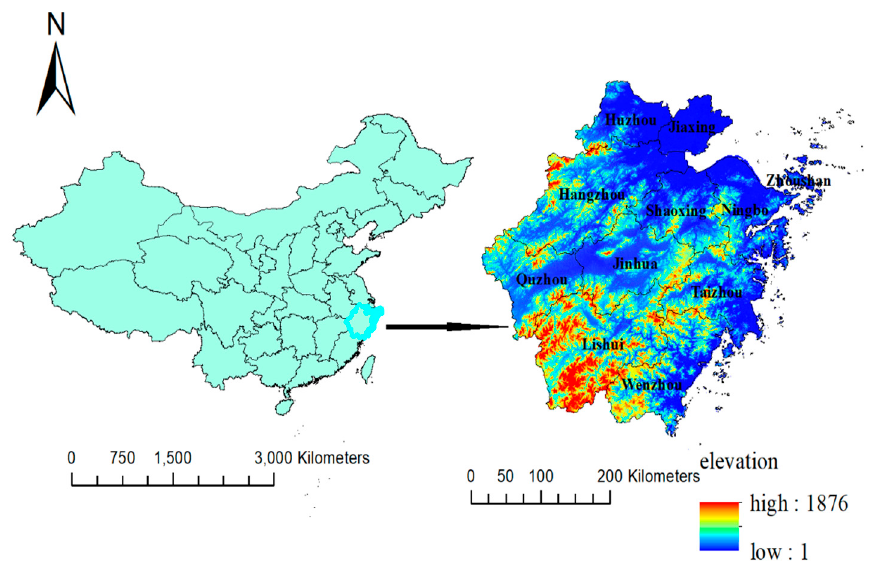
Figure 1. Location and elevation of Zhejiang Province at the municipal level. (Blue represents the low elevation, and the darker the color, the lower the elevation. Red represents high elevation, and the darker the color, the higher the elevation).